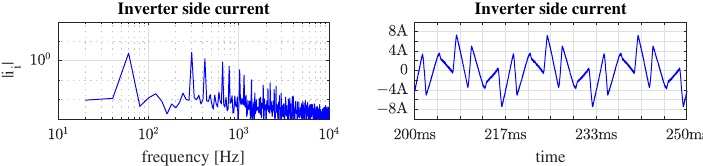
Figure 16. Inverter side current (compensation current): FFT results and waveform.